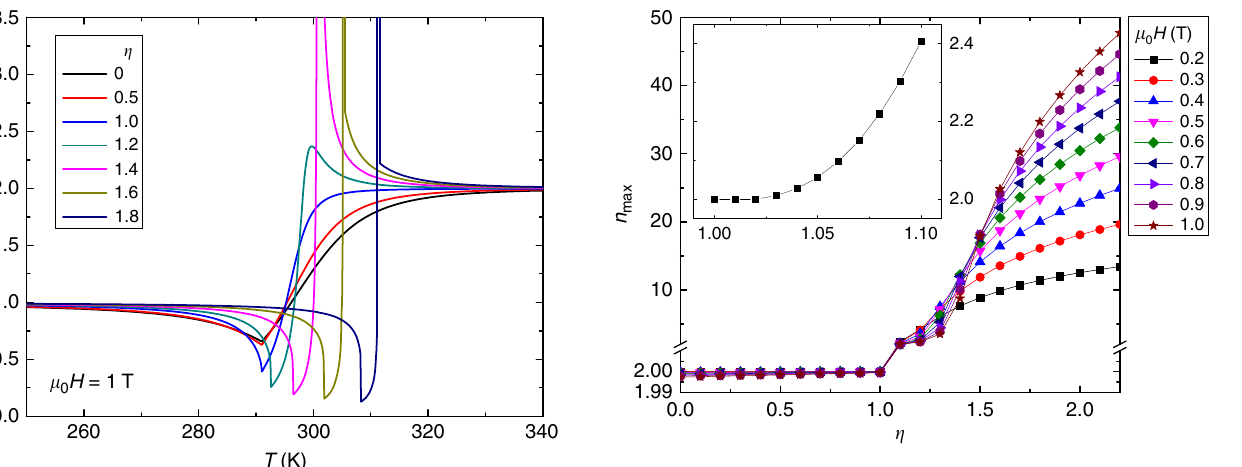
Fig. 6 In fl uence of magnetic fi eld on the maximum exponent n . Materials with a FOPT ( η > 1) exhibit an exponent value larger than 2 for all studied fi elds. Inset: higher resolution curve for a fi eld of 0.2 T in the proximity of the critical point of the second-order phase transition, where the overshoot of n > 2 is already evident for η (cid:4) 1 : 03